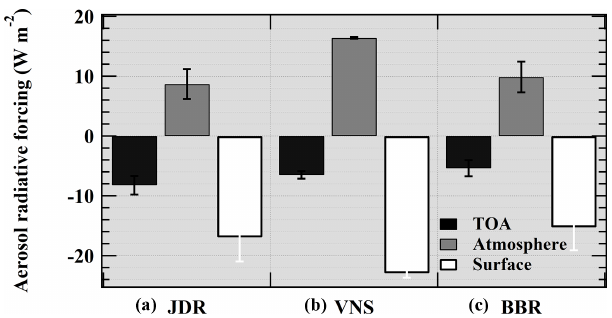
Figure 8. Aerosol-induced short-wave radiative forcing at the top of atmosphere (TOA) (filled black bar), surface (filled white bar) and atmosphere (filled grey bar) for the regions of the IGP: (a) west (JDR), (b) centre (VNS), (c) and east (BBR). Error bars represent standard deviation around the